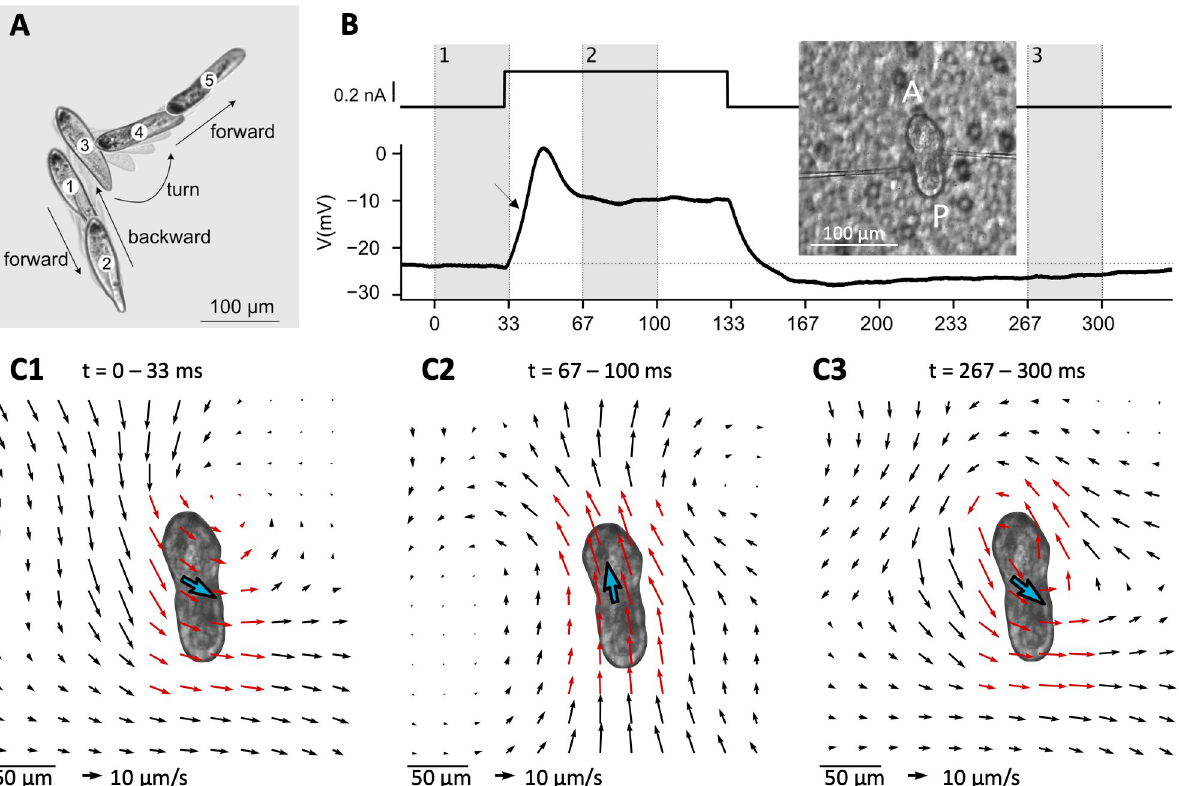
Fig 2. The avoiding reaction of Paramecium. A, Typical spontaneous avoiding reaction: the ciliate swims backward, then turns and eventually resumes forward swimming, while spinning around its main axis during the entire movement. Images are separated by 150 ms, with intermediate shaded frames every 37 ms. The cell was placed in 20 mM NaCl and 0.3 mM CaCl 2 to induce spontaneous avoiding reactions [21]. B, Intracellular recording of a voltage response (bottom right) to a square current pulse of amplitude 300 pA (top right) in an immobilized cell (left; A: anterior end; P: posterior end), showing a small action potential (in the standard extracellular solution, see Methods). The arrow points at a small upward inflexion due to the calcium current. Inset: Paramecium immobilized on a filter (background) with two electrodes. C, Velocity field of the fluid on a plane ~30 μ m above the cell, calculated over the three shaded intervals shown in B. The blue arrow indicates mean velocity in the whole field, represented twice larger for clarity. The red arrows highlight the area neighboring the cell. C1, The fluid moves backward, which would make the cell swim forward. C2, The fluid moves forward. C3, The flow direction reverts on the posterior end, but not on the anterior right end, resulting in a swirling pattern.